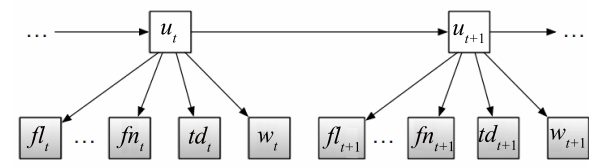
Fig. 15 Two consecutive time slices of a Flap dynamic Bayesian network for modeling user movement pattern based on n friends [62] .